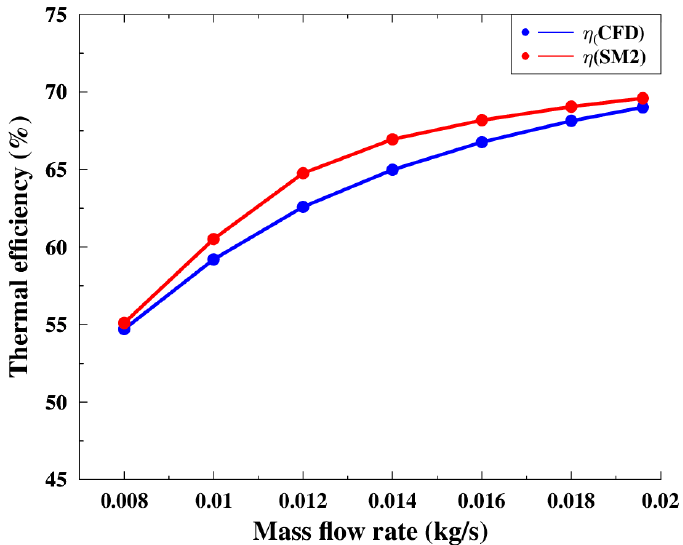
Figure 18. Variation in the thermal efficiency of the VSW with the airflow rate.